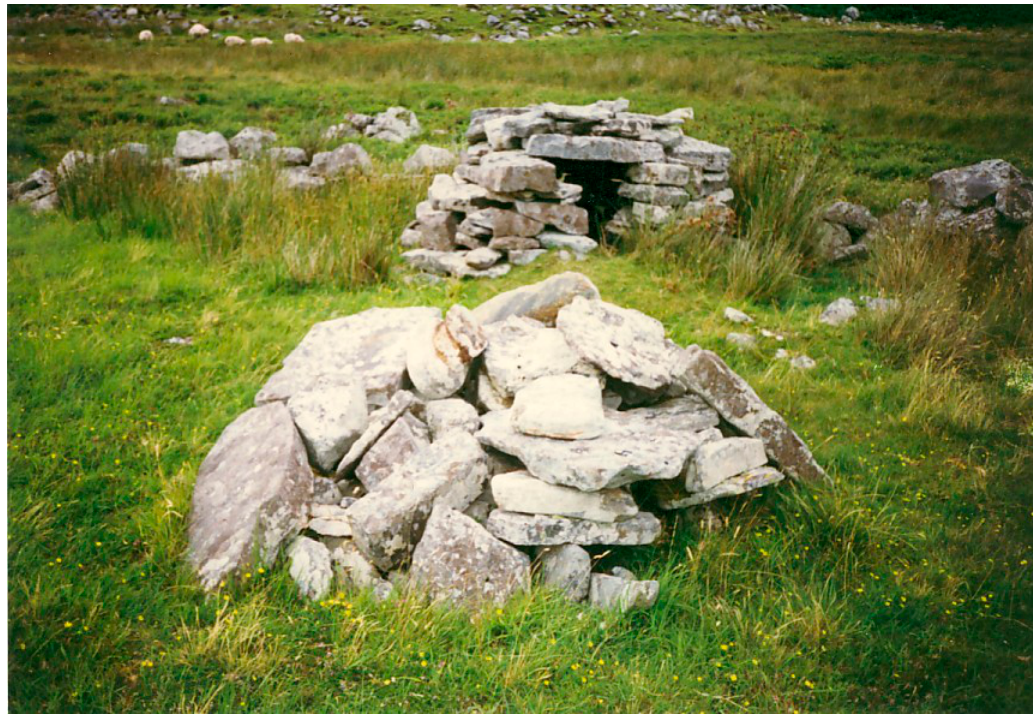
Figure 13. In the background, a sweat-house on Clare Island. There may be a number of other stations at which the pilgrims pray and which they circle, like mounds (sometimes with trees on them), objects called the graves, old churches or their ruins, graveyards, altars inside of the churches, statues. The pilgrim may also kneel and pray at the entrance to the well or other object. The pilgrim may kiss some items there, like figures, or may sign those items and herself/himself with the sign of the cross (as practiced at Tobar na Mult —the Well of the Wethers at Ardfert, Co. Kerry), or may sign herself/himself with those items making the sign of the cross. Kissing the stone under the window inside the ruins of the church, where once the altar was, after putting a leaf in the window, was common during the visit at St. Moling’s Well at St. Mullins (Co.